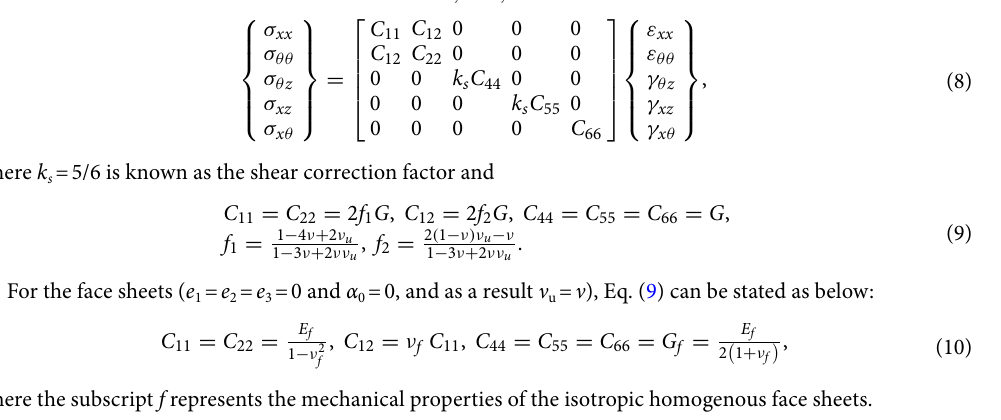
where B 0 is known as the Skempton coefficient which deputizes the compressibility of the pore fluid. By increas- ing the Skempton coefficient from zero to one, the pore fluid varies from a completely compressible fluid to a noncompressible fluid. For the undrained condition ( ξ = 0), the plane stress assumption ( σ zz = 0), and employing Eqs. (6) and (7), Eq. (5) can be stated in x - θ - z coordinates as below ( γ ij = 2 ε ij ):